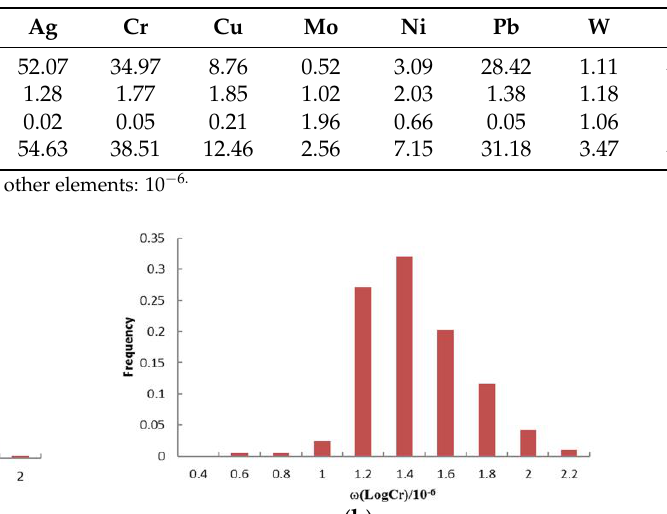
Table 1. The eigenvalues of each element after iteration.